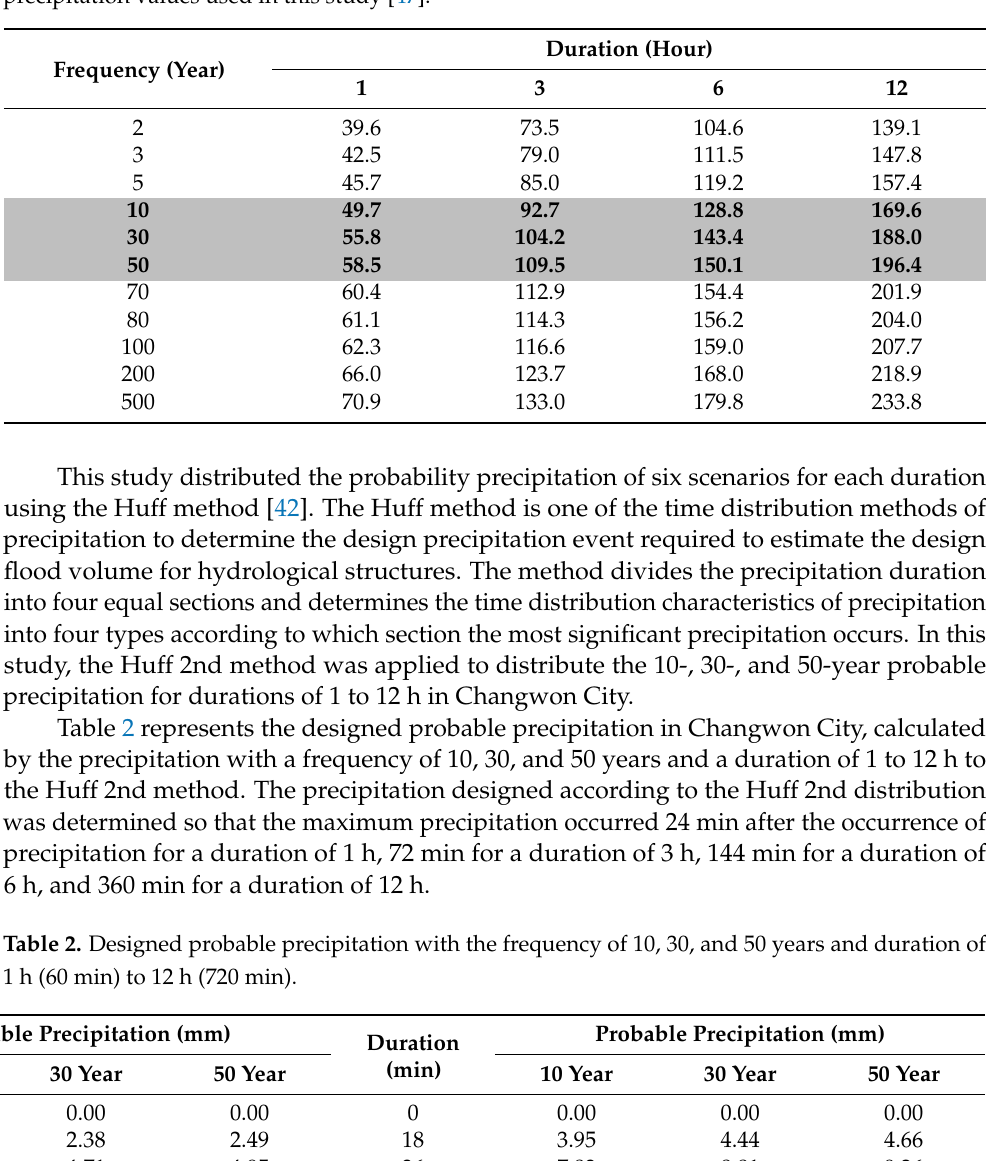
Table 1. The probable precipitation in Changwon City, South Korea. A grey box indicates the probable precipitation values used in this study [47].